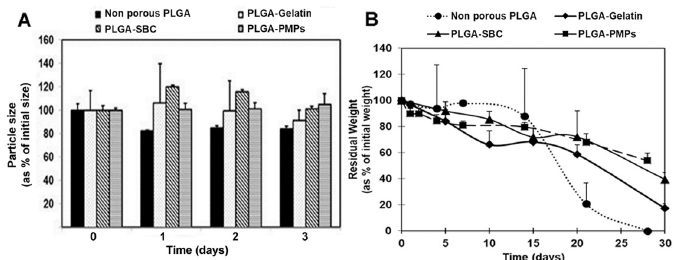
Fig 2. Physical characterization of porous PLGA MPs. (A) Particle stability in 10% serum indicating that non- porous PLGA, PLGA-SBC, PLGA-Gelatin, and PLGA-PMPs maintained their diameter and granulometric properties for 3 days. (B) Degradation of porous PLGA MPs investigated at 37˚C for 4 weeks. PLGA-Gelatin particles degraded 83% of their initial weight in 28 days while PLGA-SBC particles and PLGA-PMPs were reduced to 61% and 46% of their original weight, respectively. The data plotted in terms of average ± standard error obtained from samples size (n) of